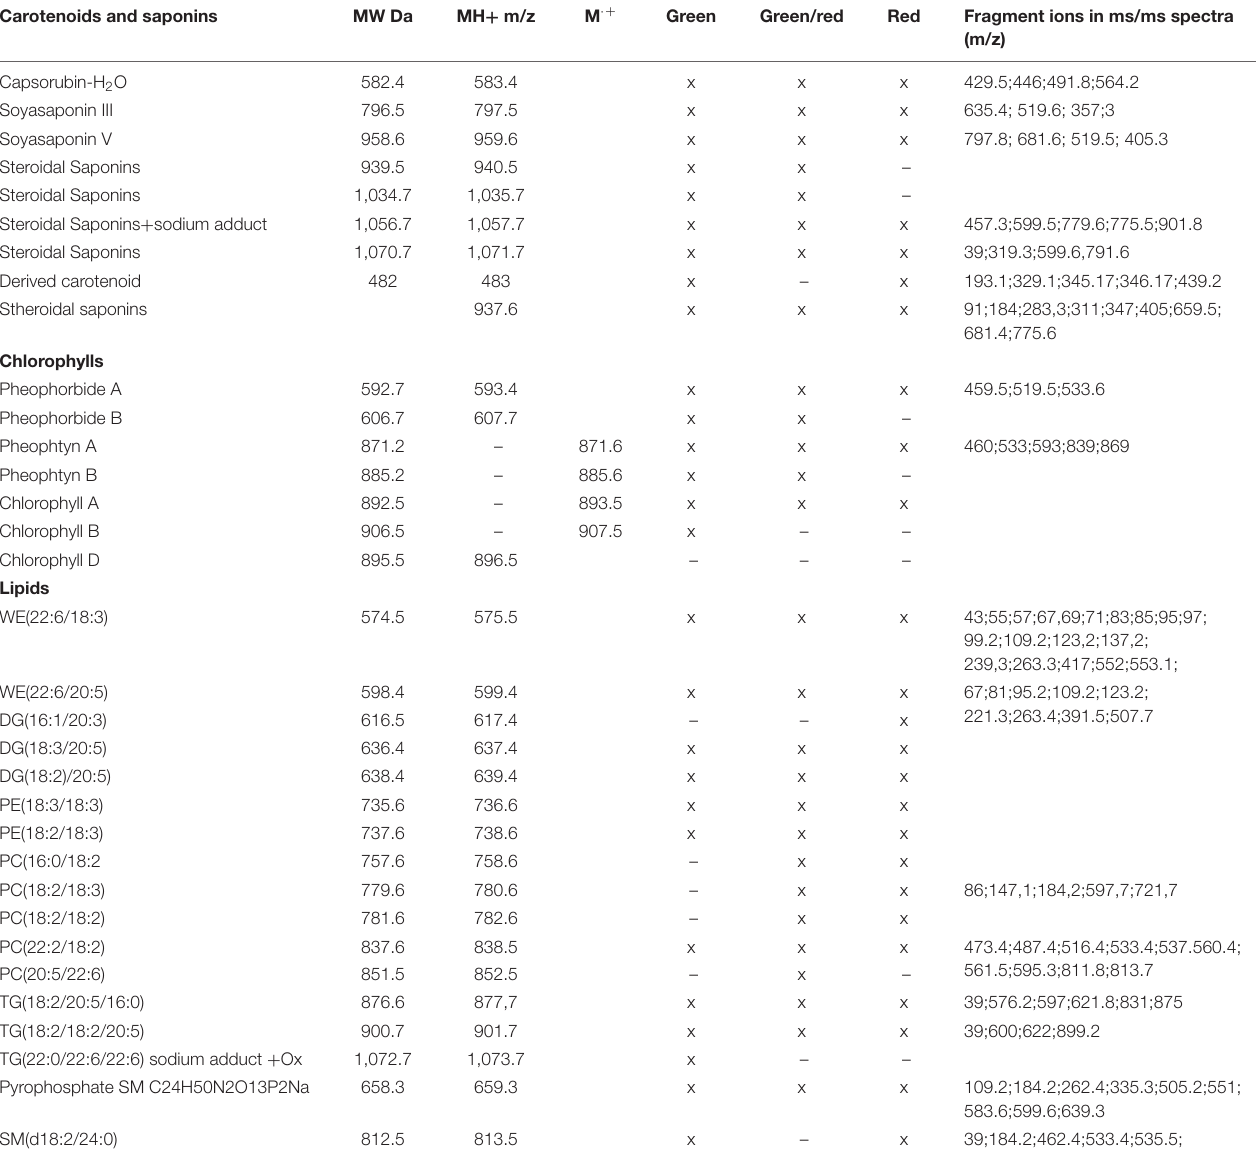
TABLE 1 | List of the theoretical and experimental masses of parent ions MH + m/z or M ·+ m/z is presented. Carotenoids and saponins MW Da MH + m/z M ·+ Green Green/red Red Fragment ions in ms/ms spectra